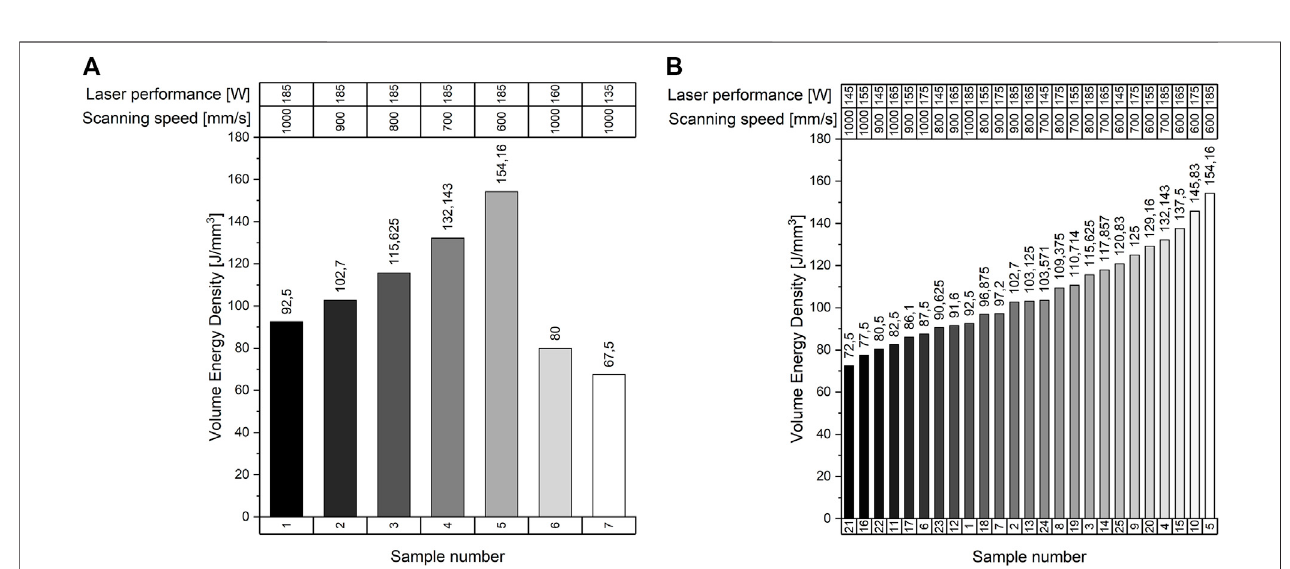
FIGURE 2 | Printing parameters of the HEA coatings (A) and parameters of the rectangular prism (B) .